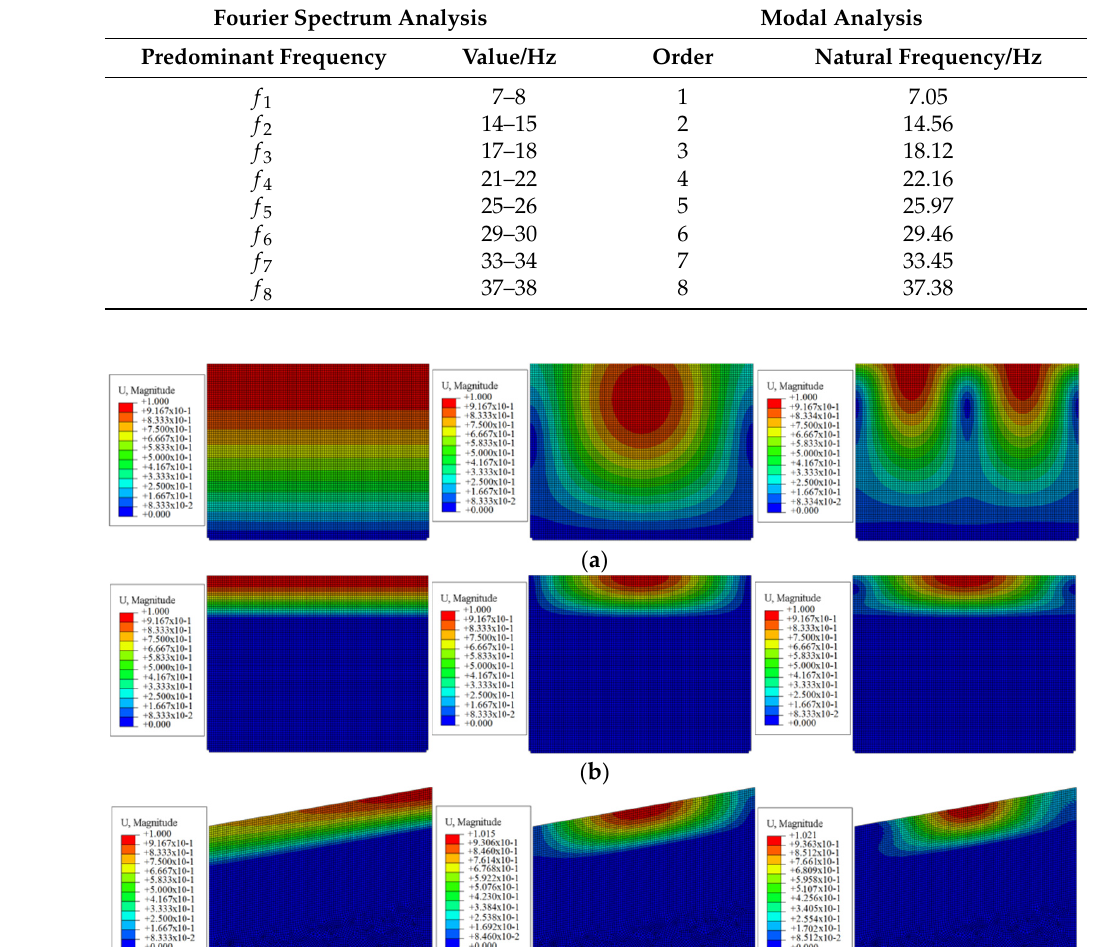
Table 3. The predominant frequency and modal analysis results of Model 2.